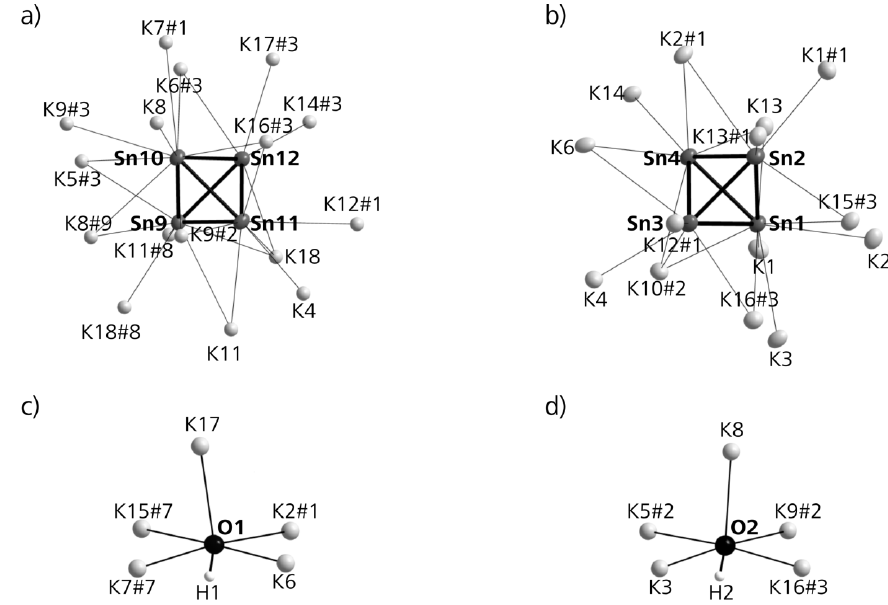
Figure 7. Cationic coordination spheres of the two anionic components in K 4.5 Sn 4 (OH) 0.5 ·1.75NH 3 ; ( a ) ( a ) [Sn 4 ] 4 − sourrounded by 16 cations; ( b ) [Sn 4 ] 4 − coordinated by 14 cations, as a represantive